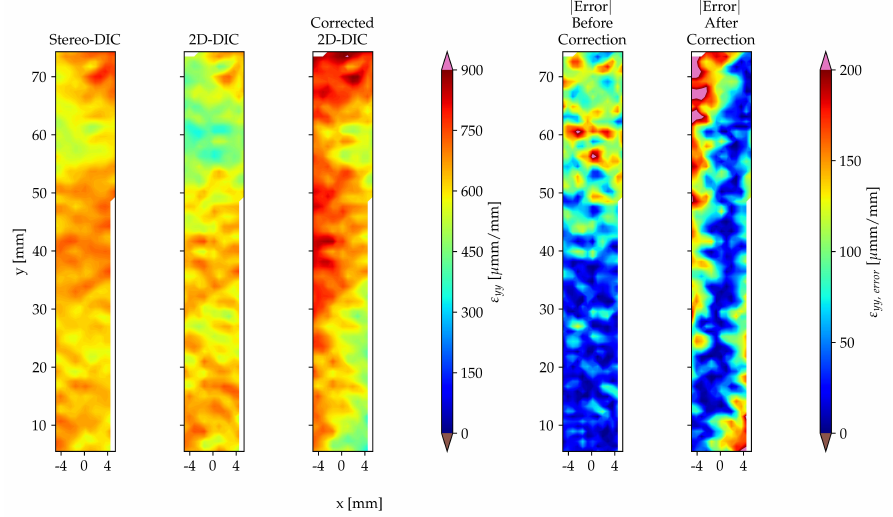
Figure 6. Results from the application of the compensation method to the 2D-DIC measurement taken in Test 4, for the last image taken in the tensile test. The root-mean-square (RMS) error of all strain measurements across the region-of-